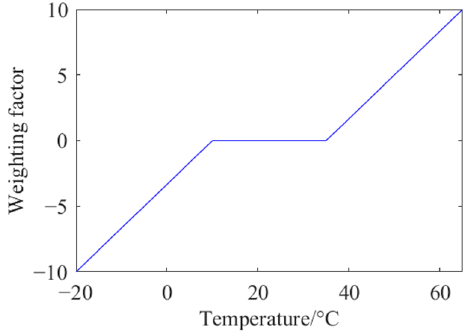
10 of 20 Figure 7. SOC reference trajectory. 3.3. PMP-MPC Framework The required power of HEAGV is expressed as =